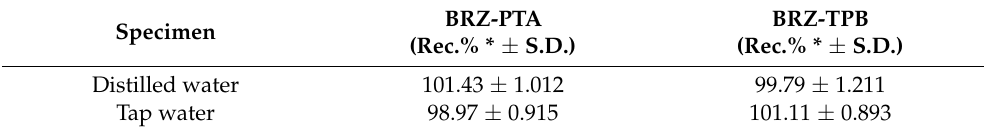
Table 3. Determination of BRZ in spiked water samples using the fabricated membrane sensors.